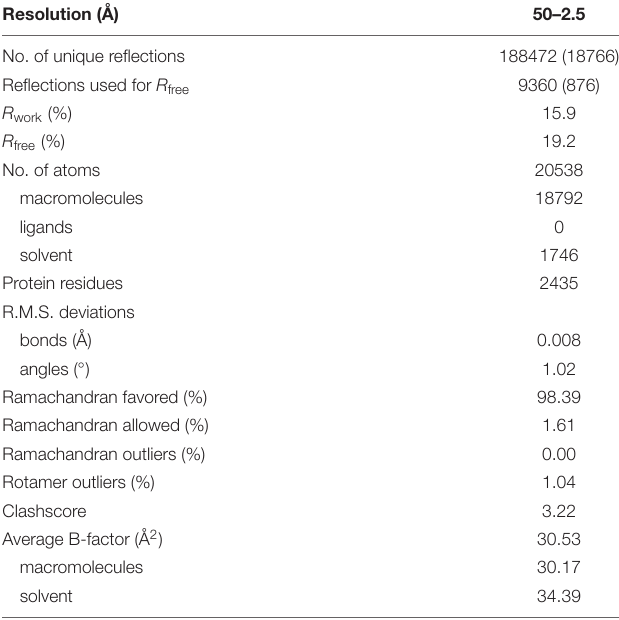
TABLE 2 | Structural refinement statistics of R. castenholzii